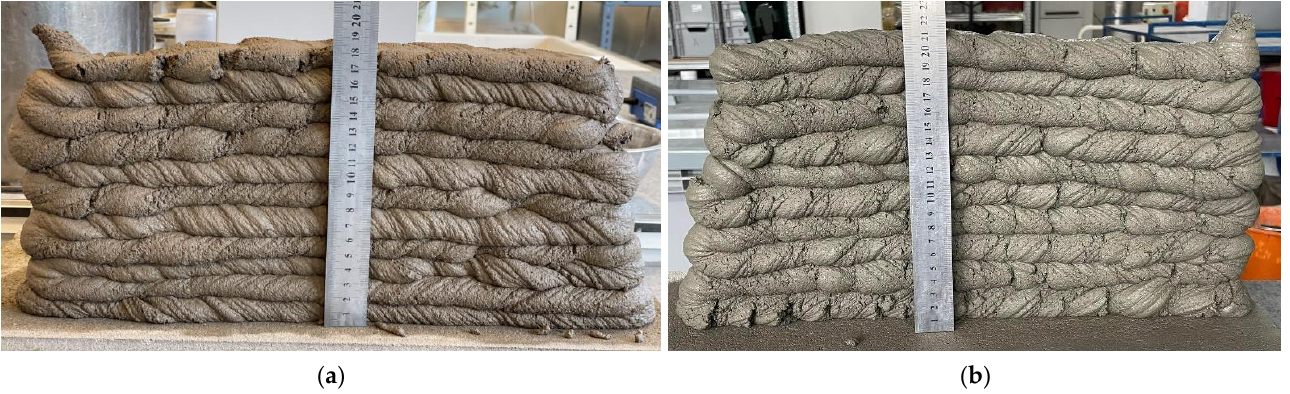
Figure 10. Examples of mixtures that have not collapsed before reaching demanded number of lay- ers and thus succeeded to meet the requirements of the test ( a ) mixture SAP_35HFA, ( b ) mixture SAP.